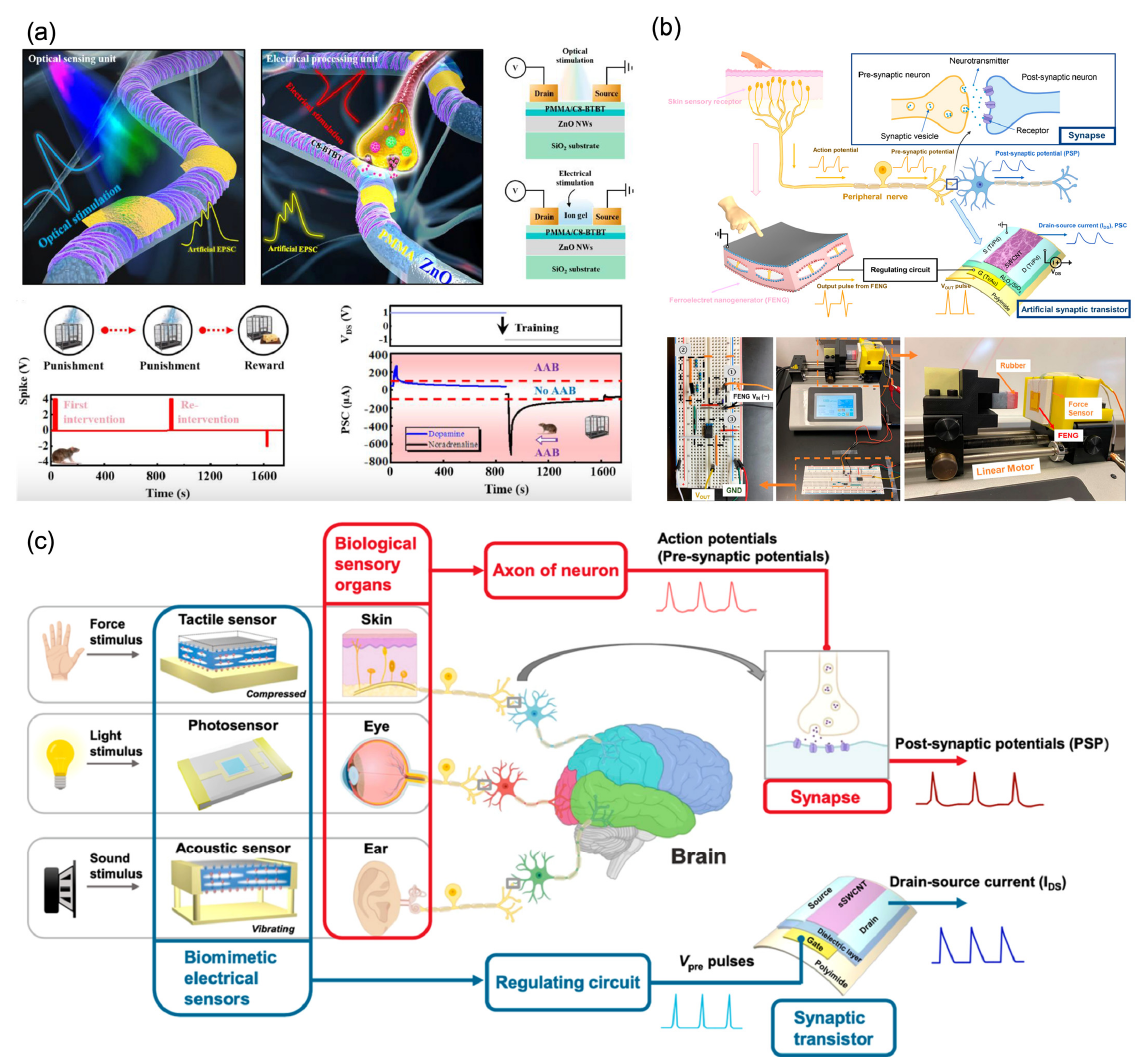
Figure 12. ( a ) A photoelectric neuromorphic transistor composed of ZnO nanowire with a PMMA/C8-BTBT decorated sheath [105]. Reprinted/adapted with permission from Ref. [105] Yang, 2012 ( b ) Schematic illustration of biological skin and synapse, in comparison with their artificial electrical counterpart [106]. Reprinted/adapted with permission from Ref. [106] Yang, 2014 ( c ) Schematic illustration of biological visual, auditory, and tactile sensory organs and the process of information transmission and storage through neuron and synapse [107] Reprinted/adapted with permission from Ref. [107] Yang 2009.